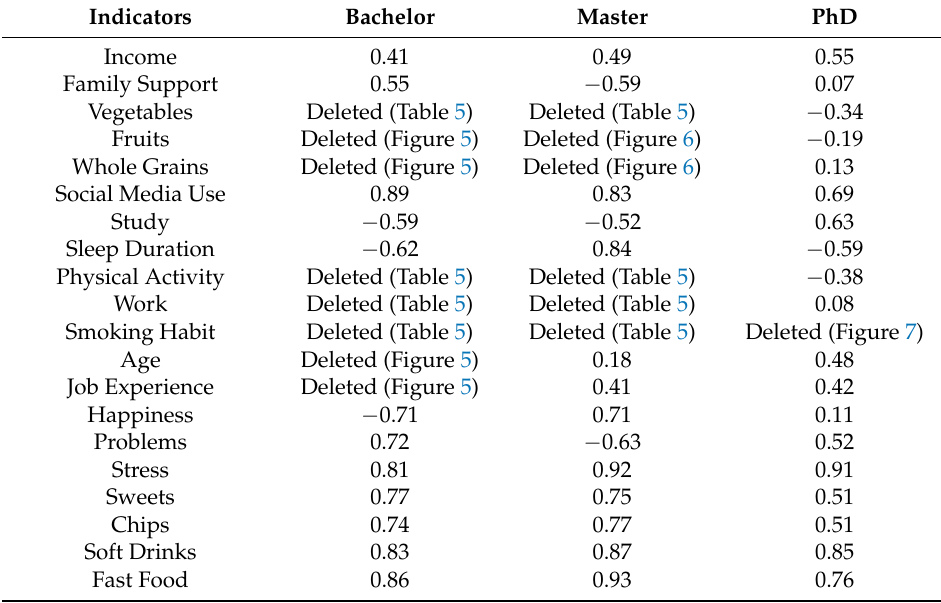
Table 8. Pearson correlation results for the most significant indicators from the BSEM